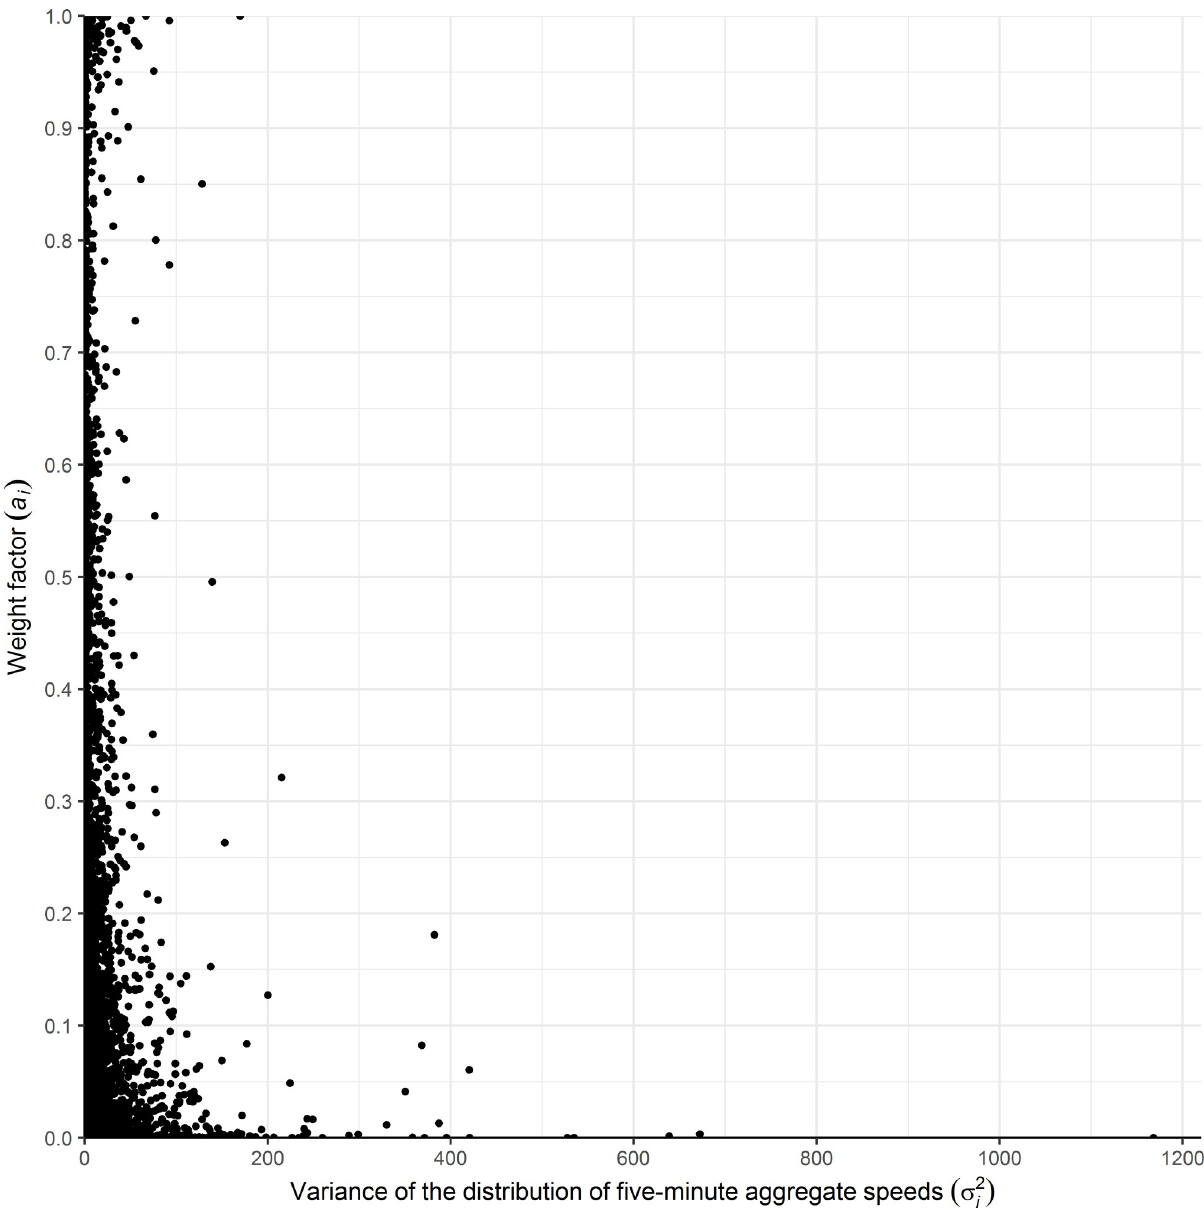
Fig 10. Weight factor VS the variance of the distributions of five-minute aggregate